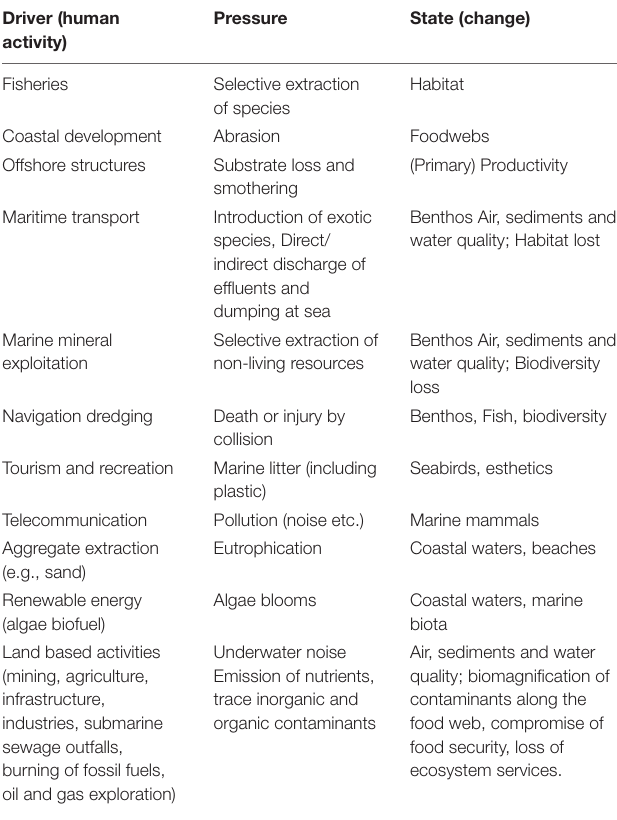
TABLE 1 | Drivers, pressures and state